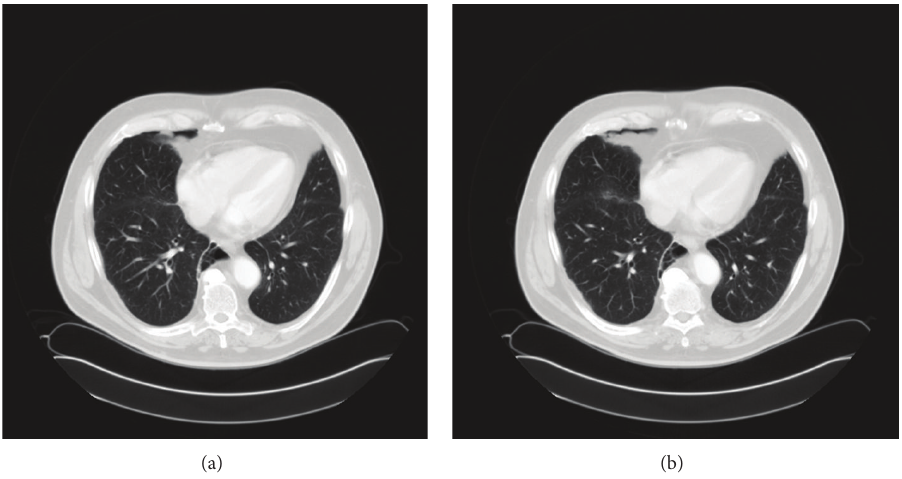
Figure 1: Chest CT scan in September 2007 showing a small anterior right pneumothorax.